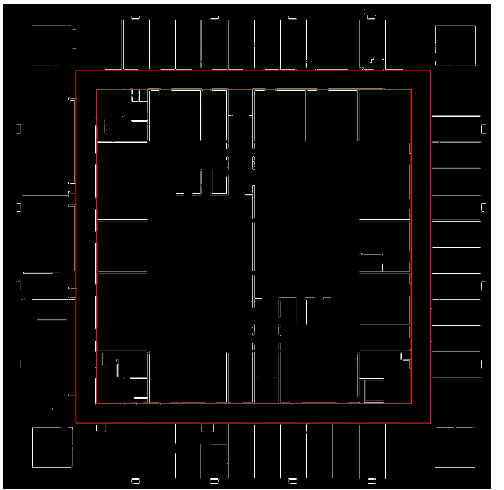
Figure 4. BCAD and the extracted corridor, where walls are in white and the corridor is in red.